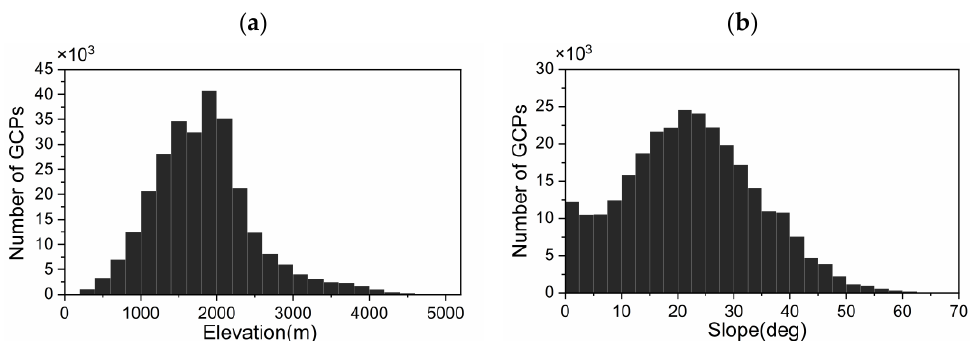
Figure 3. The distribution of the number of GCPs: ( a ) distribution on different elevations; ( b ) distri- bution on different slopes.